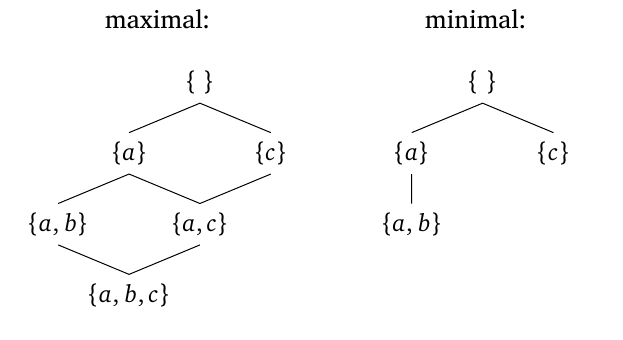
Figure 7: Example of maximal and minimal models of type constraints over conjunctive